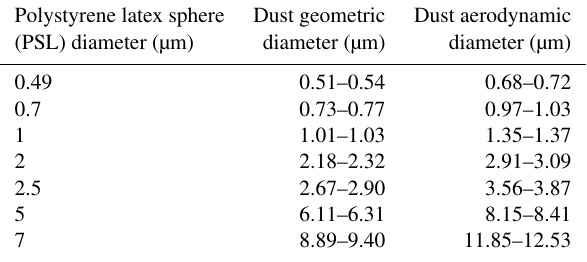
Table 1. The dust geometric and aerodynamic diameters of the seven bin boundaries. Determination of the geometric diame- ter ranges uses Lorenz–Mie theory such that they produce the same range of scattered light intensity as the seven manufacturer- provided polystyrene latex sphere (PSL) diameter sizes. The ranges in geometric diameters derive from the uncertainty in the dust re- fractive indices. We determined the aerodynamic diameter ranges by applying Eq. (6) to the geometric diameter ranges. Polystyrene latex sphere